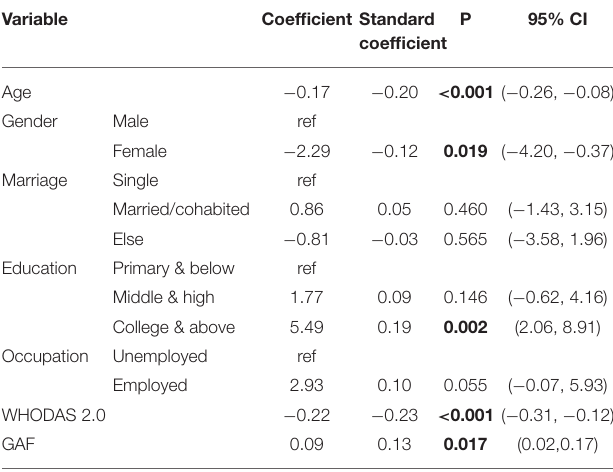
TABLE 3 | Multivariate linear regression of recovery. a